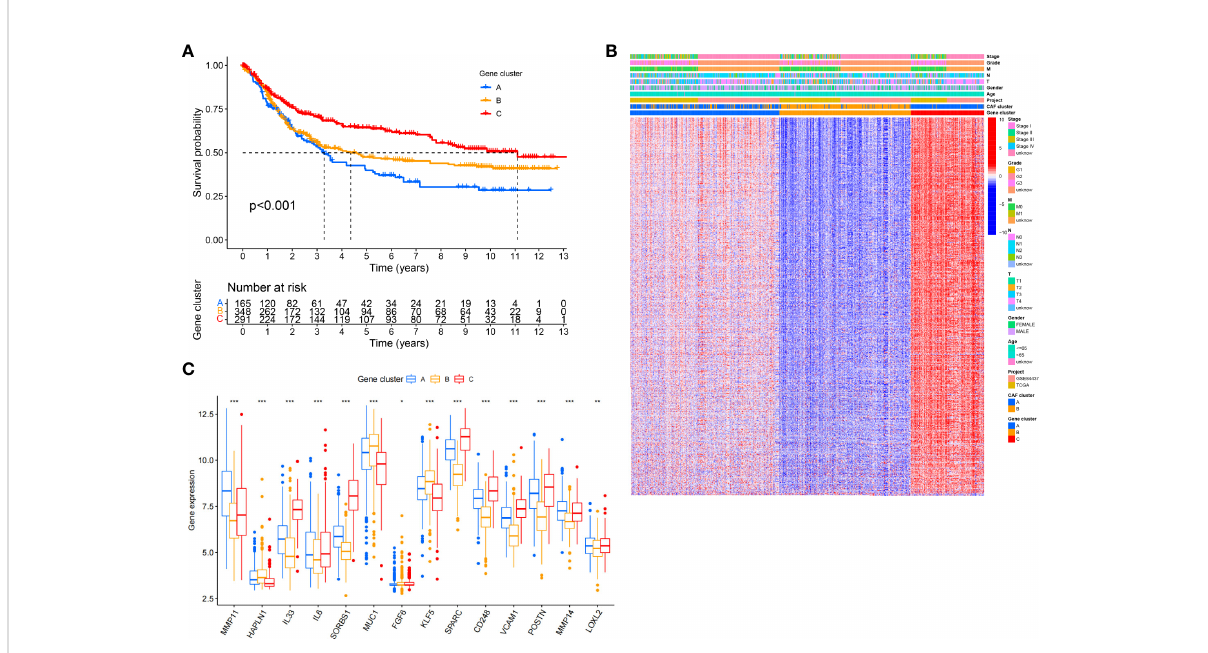
FIGURE 3 Identi fi cation of gene subtypes based on DEGs. (A) Kaplan-Meier curves for RFS of the three gene subtypes (log-rank tests, p < 0.001). (B) Relationships between clinicopathologic features and the three gene subtypes. (C) Differences in the expression of 18 CAFs-related genes among the three gene subtypes. *P<0.05, **P<0.01,